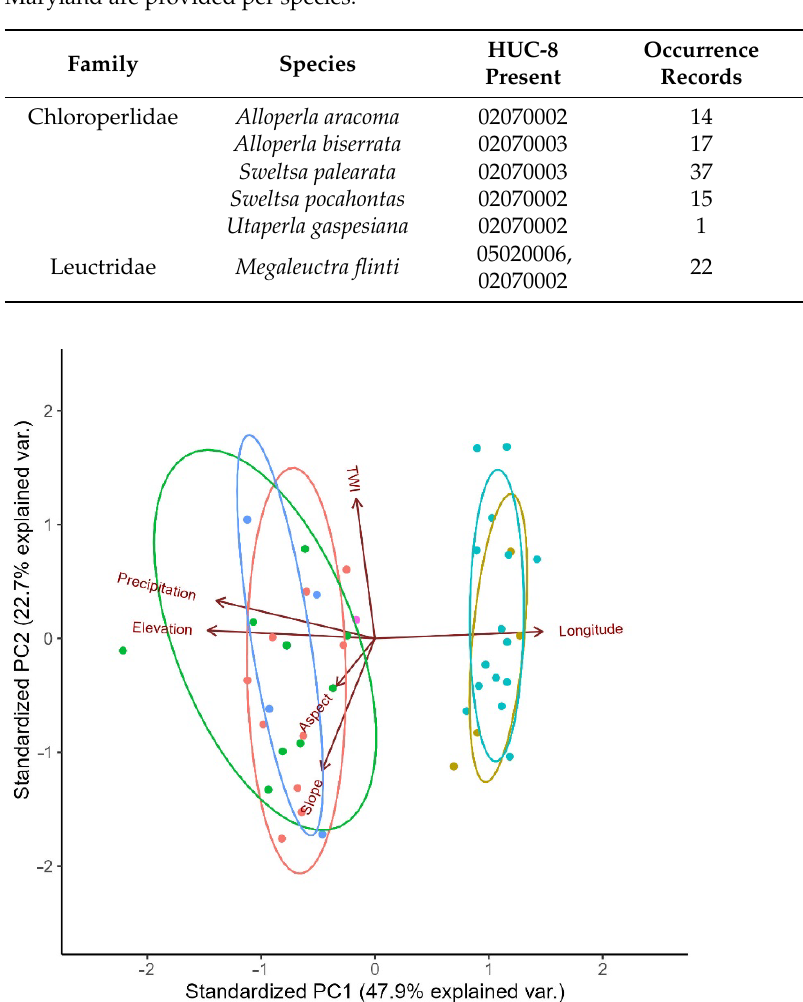
Table 14. Stonefly Species of Greatest Conservation Need (SGCNs) listed in USA states adjacent to Maryland with recorded presence within Maryland yet are not listed on the Maryland State Wildlife Action Plan (SWAP). USGS Hydrologic Unit Code (HUC)-8 basins with known Maryland presence are indicated. Number of Maryland records and elevation of collection localities are provided. State abbreviations are as follows: Delaware (DE), Pennsylvania (PA), Virginia (VA), and West Virginia (WV).